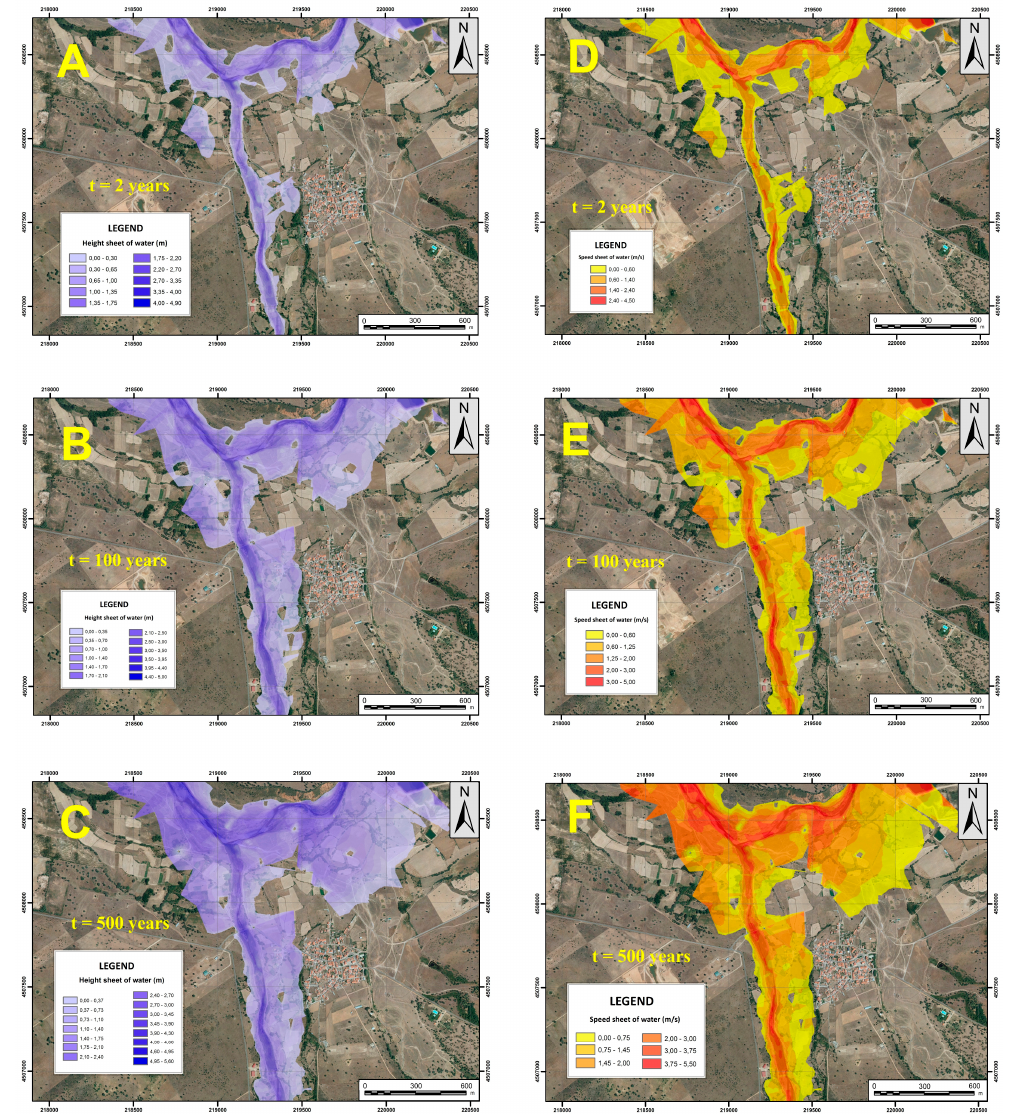
Figure 8. ( A – C ) Depth of the water surface (isobaths) for 2, 100, and 500 years; and ( D – F ) distribution of flow rates (isotachs) for 2, 100, and 500 years.